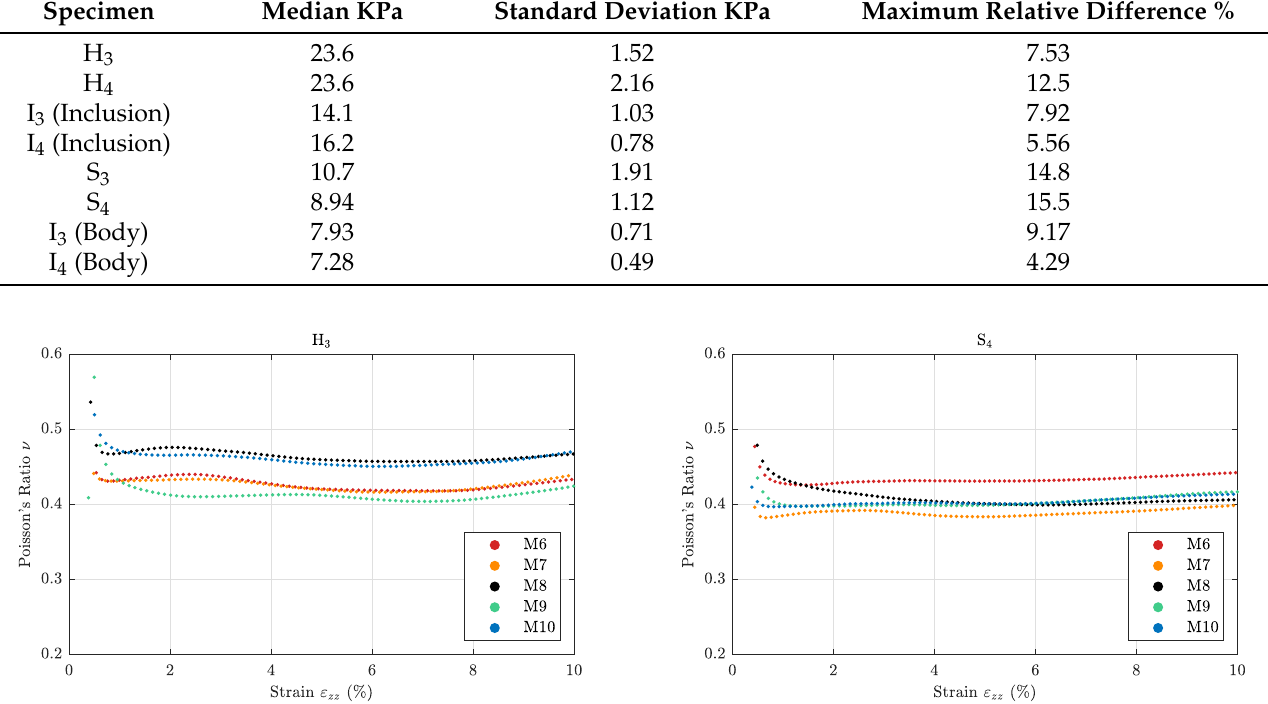
Table 3. Combined results of the elastography algorithm and the statistical indicators.